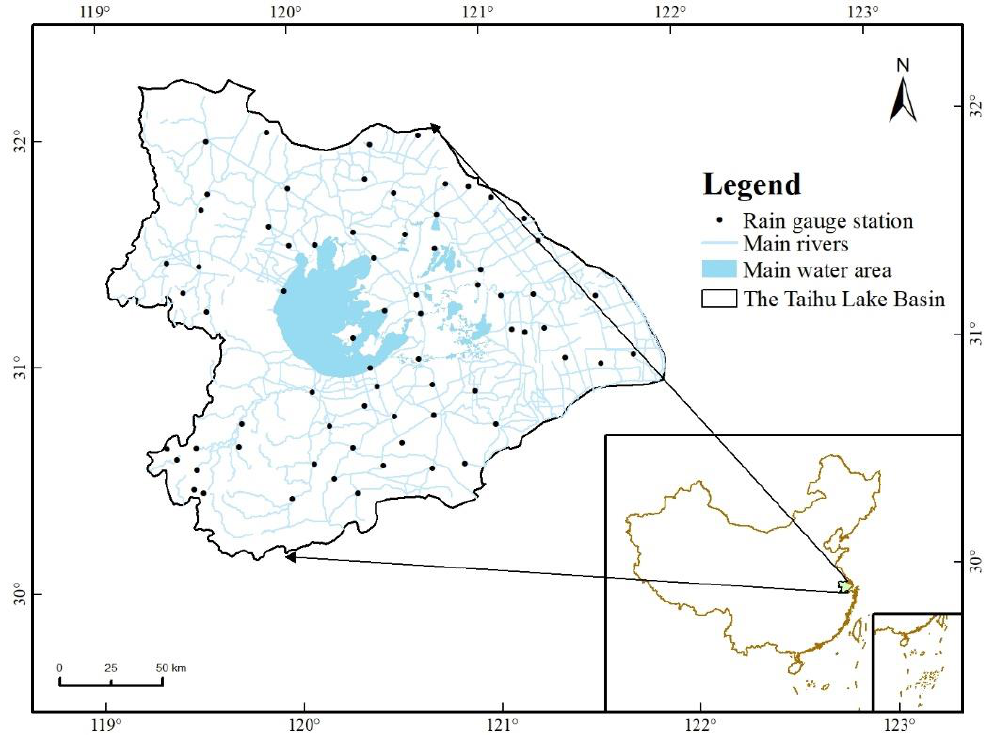
Figure 1. Map of the study area and location of the rain gauge stations.